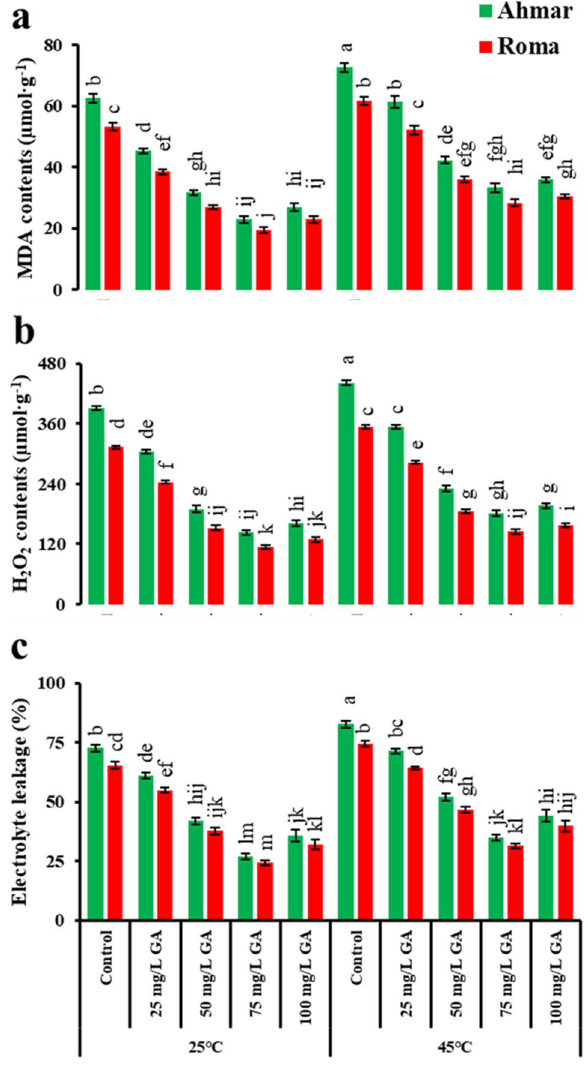
Figure 4. Oxidative stress indicators of tomato as affected by temperature, genotype and exogenous application of GA 3 . According to Tukey’s honestly significant difference test, the same letters suggest that there is no statistically significant difference between treatments ( p ≤ 0.05). Vertical bars indicate average ± standard error (n = 4, 5 plants per